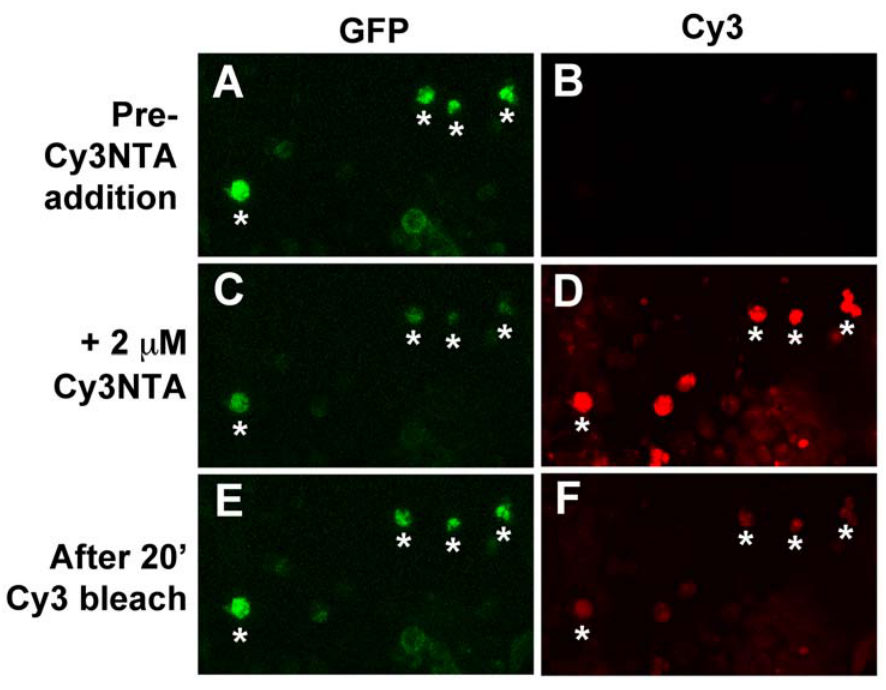
Figure 5. Cy3NTA quenches GFP-RyR1 (N-term His) fluorescence via FRET. HEK-293T cells expressing GFP-RyR1 (N-term His) were examined for GFP (panels A,C,E) and Cy3 fluorescence (B,D,E) either before (A,B) or after (C,D) a 30 min incubation with 2 m M Cy3NTA. Cy3 fluorescence was observed both in HEK-293T cells expressing GFP-RyR1(N-term His) (asterisks) and untransfected cells. Cy3 was then selectively bleached via 20 min illumination with 550 nm light resulting in an increase in GFP fluorescence (panel E) and a decrease in Cy3 fluorescence